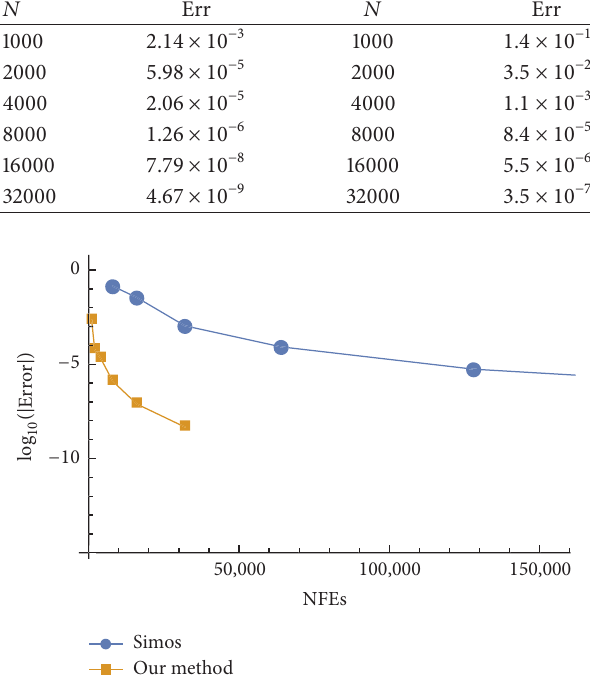
Figure 2: Efficiency curve for Example